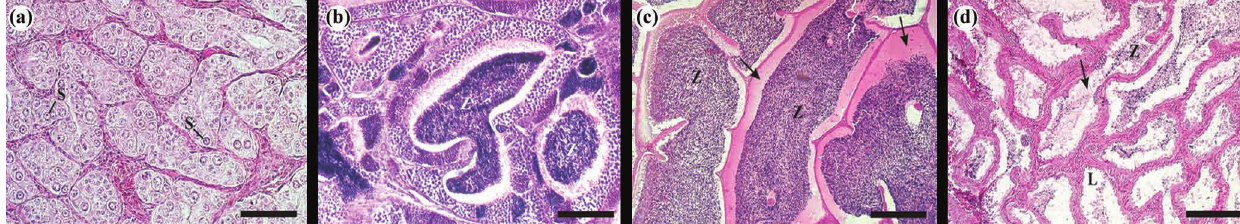
Fig. 3. Histological sections of Brycon orthotaenia testis stained with Hematoxilin-eosin: (a) resting stage with seminiferous tubules cointaining only spermatogonia (S), (b)(c) maturing/mature with seminiferous tubules full of spermatozoa (Z) in acidophilic secretion (arrows) and (d) spent testis with few spermatozoa (Z) in the lumen (L) in acidophilic secretion (arrow). Bar = (a) 30 µm, (b), (d) 70 µm, (c) 80